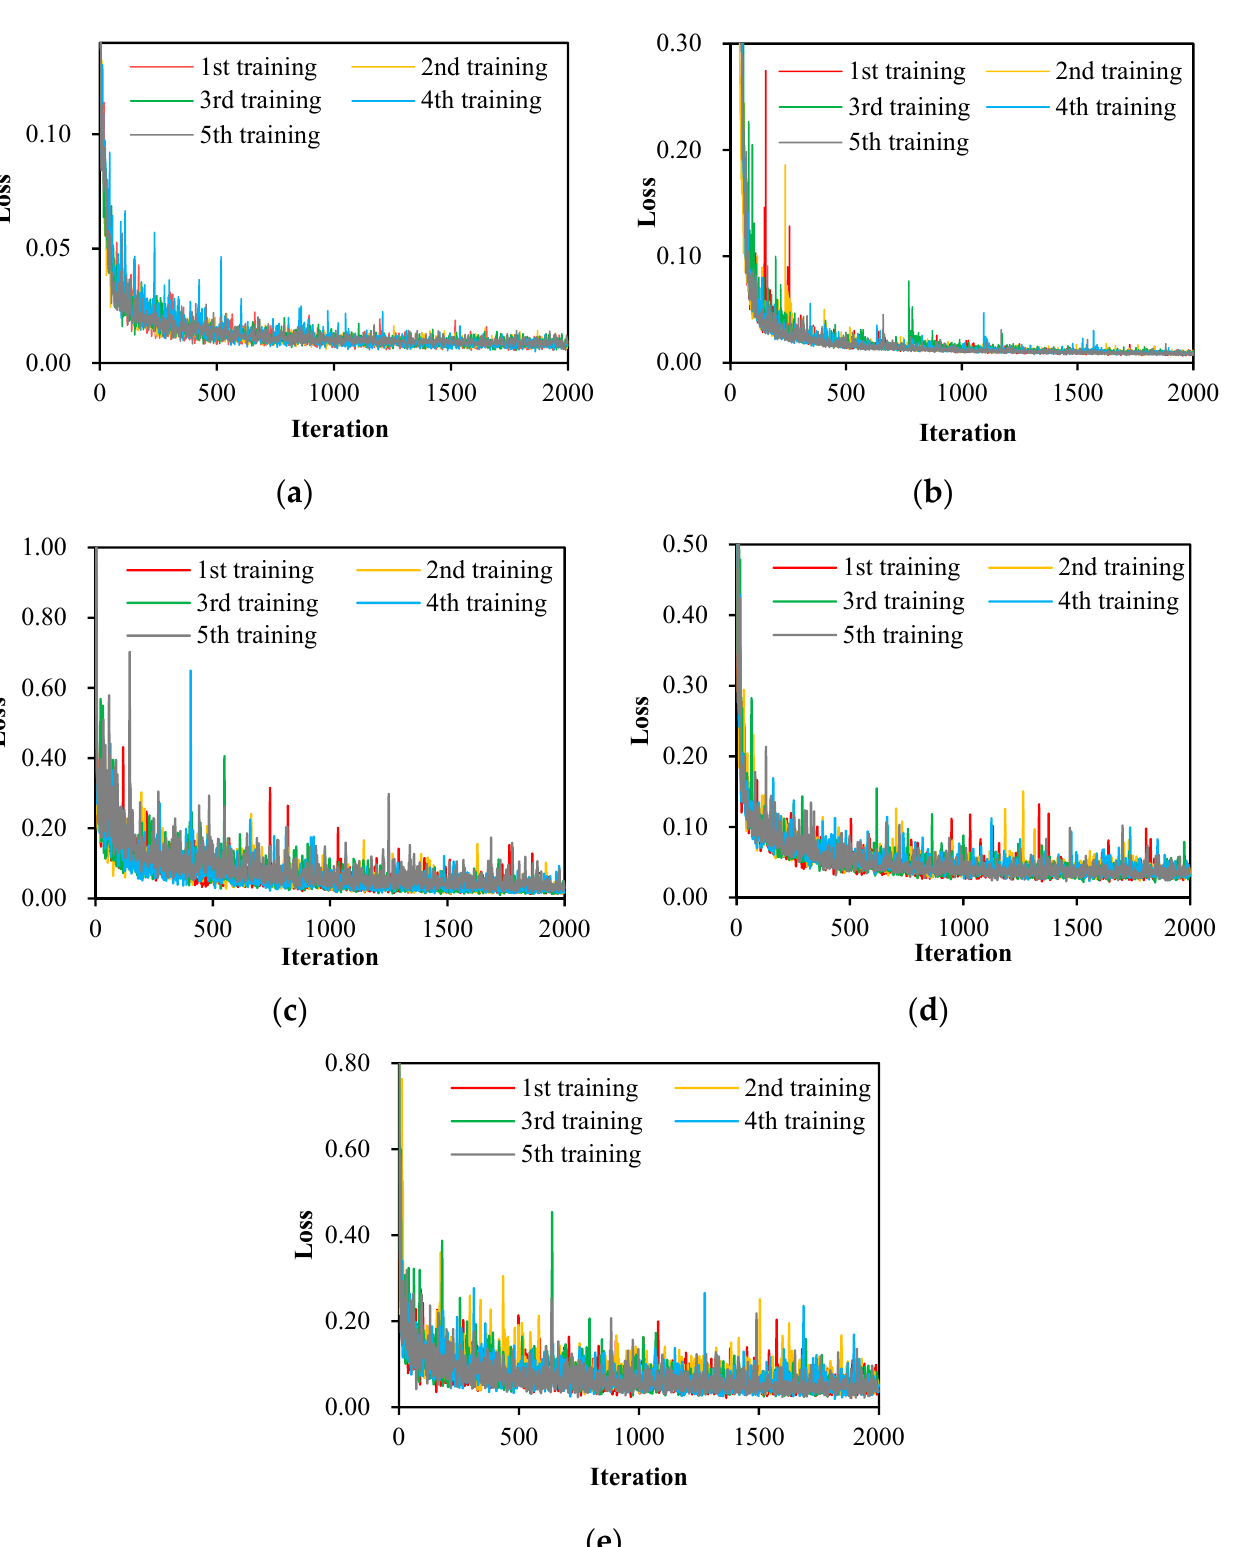
SegNet, ( c ) U-Net, ( d ) PSPNet, and ( e ) DeepLabv3+. Net, ( c ) U-Net, ( d ) PSPNet, and ( e )